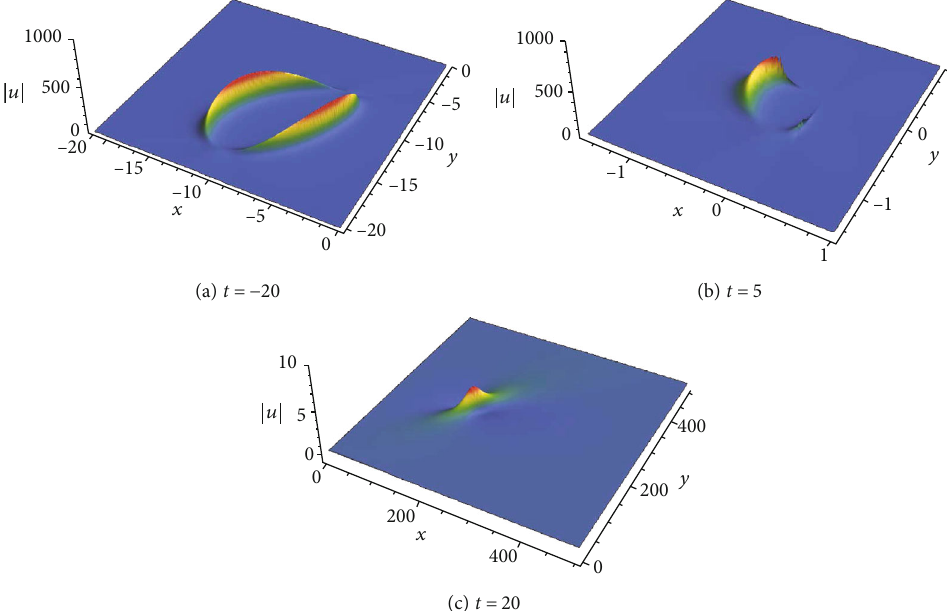
= − 0 : 6 , and a = 0 : 8 . 2 6